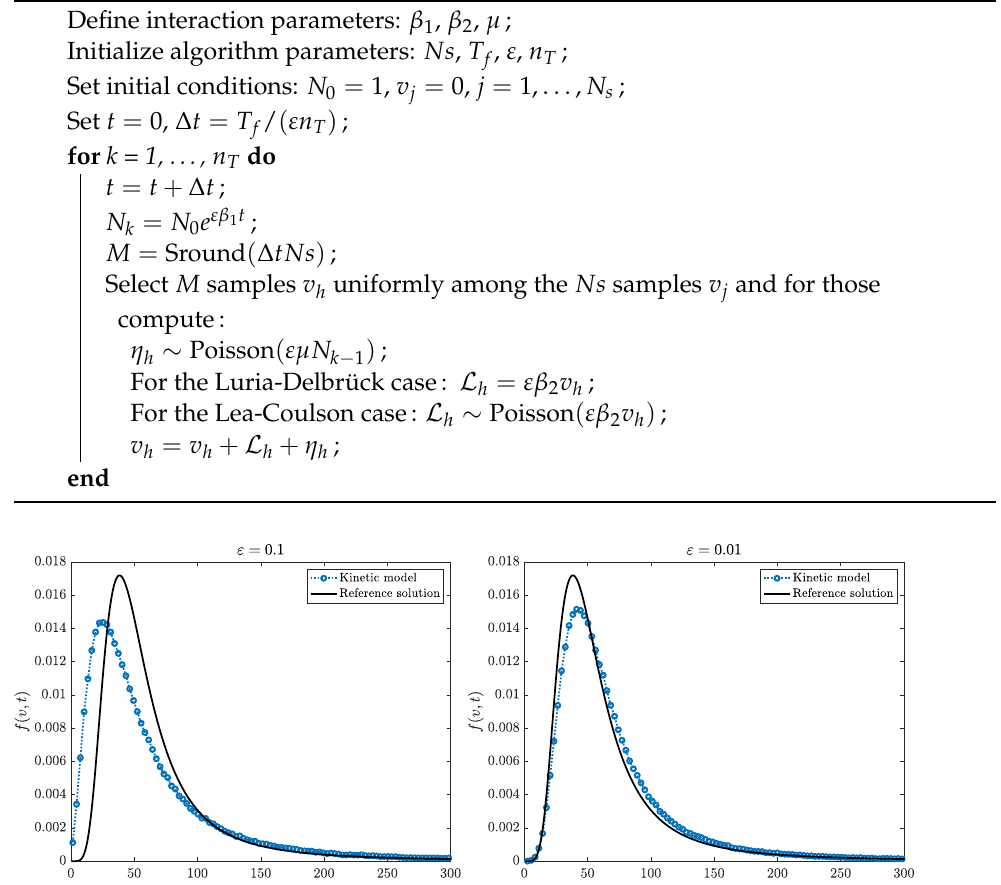
Algorithm 1: Monte Carlo method for the kinetic model (18) under scaling (33).